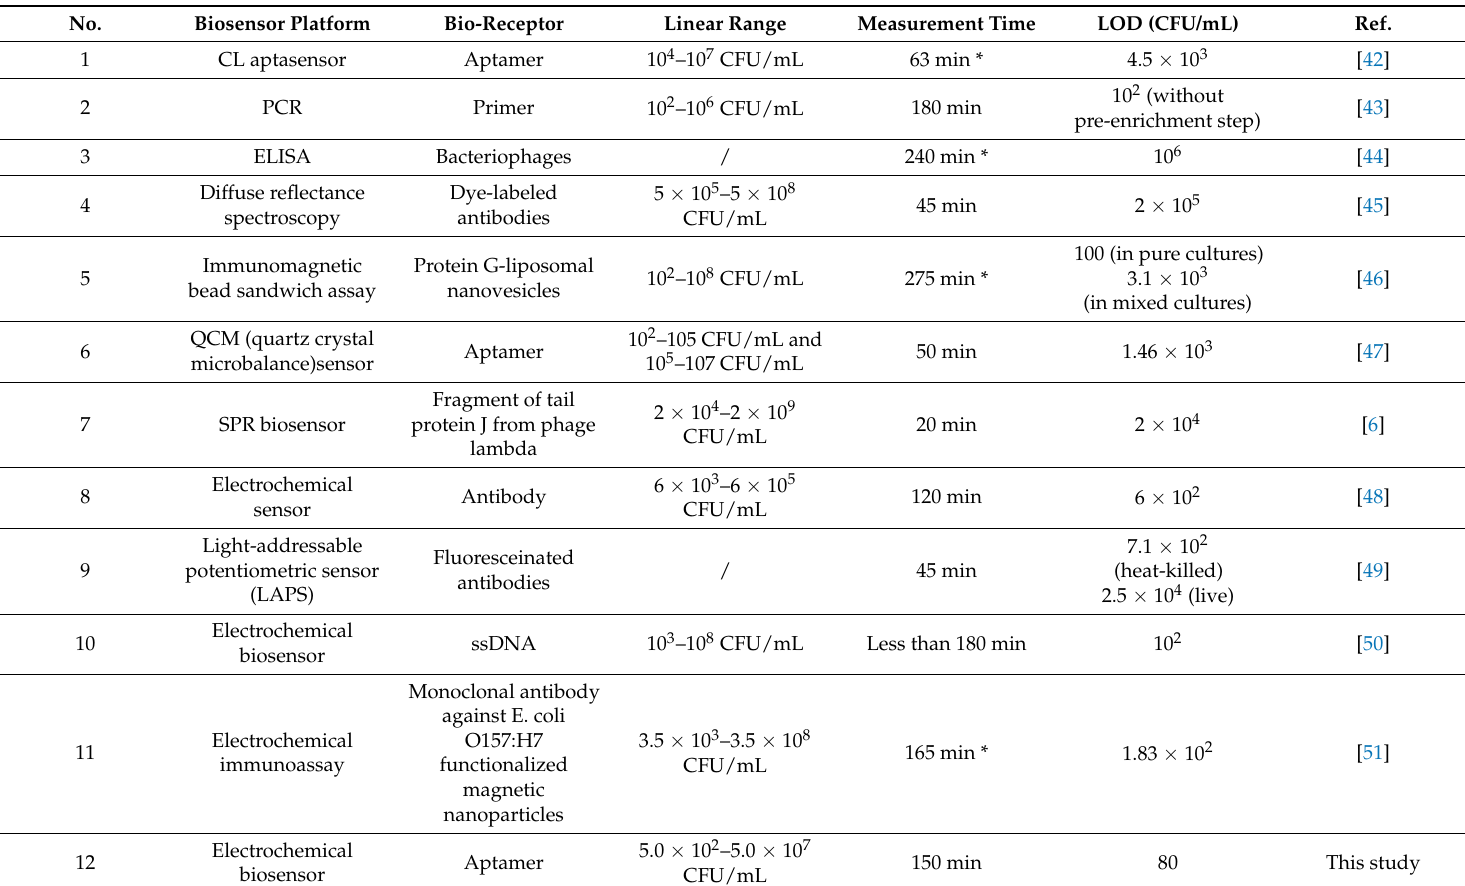
Table 1. Comparison between the proposed method and other reported biosensors for the detection of E. coli